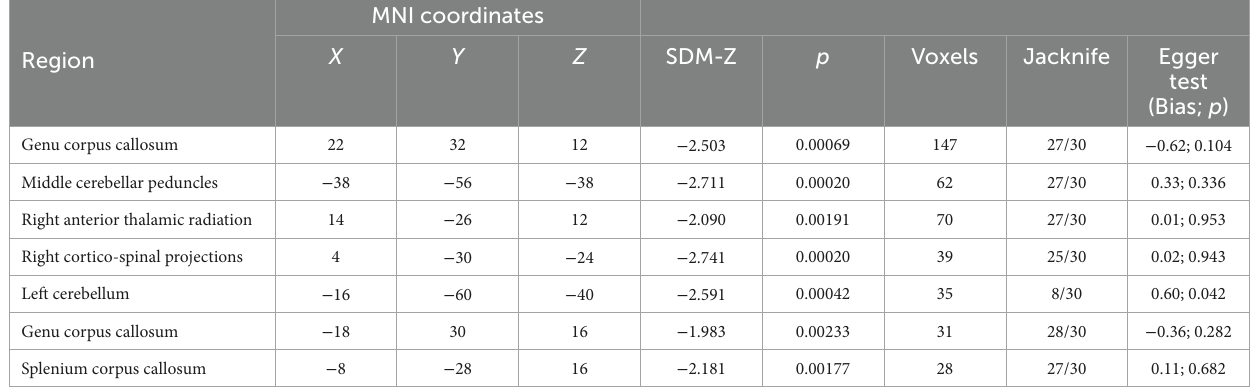
TABLE 3 Results of SDM spatial voxel-based meta-analysis.